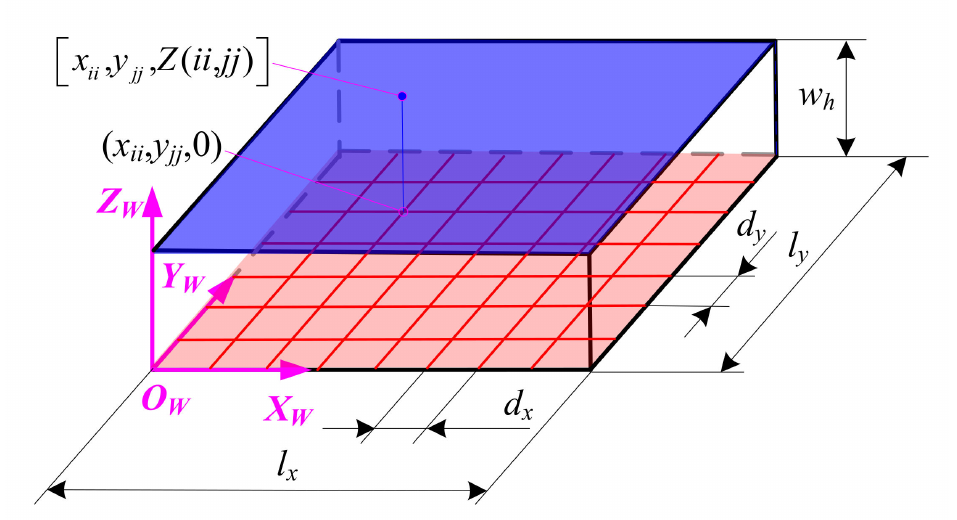
Figure 4. Z-MAP model of the